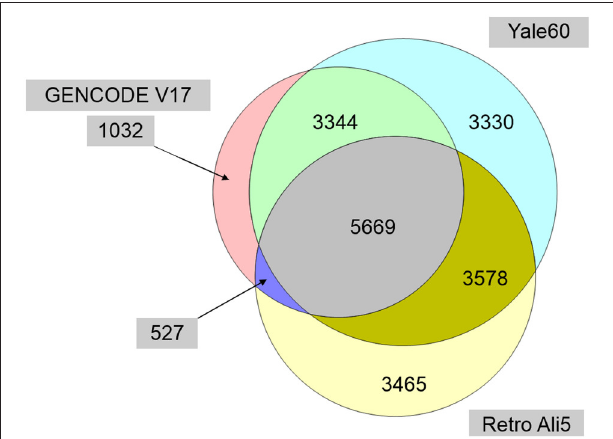
FIGURE 5 | Venn diagram of the genomic positionally-nonredundant intersection of three major public pseudogene databases. The resulting non-redundant dataset (Supplementary Dataset 3) renders a more inclusive and comprehensive pseudogene database of 20945 pseudogene loci and alleviates problems due to accession number synonymity within and between the three databases. (Accession number synonyms point to the same pseudogene along the human genome, but in the absence of positionally-nonredundant collapsing, they may be misrepresented by downstream programs as representing multiple